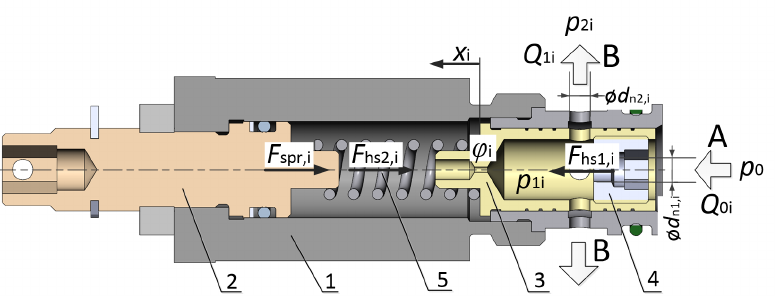
Figure 3. Cross-sectional view of a flow control valve: 1—body; 2—spring tension adjuster; 3—spool; 4—control insert with a nozzle; 5—spring; A—input; B—output.